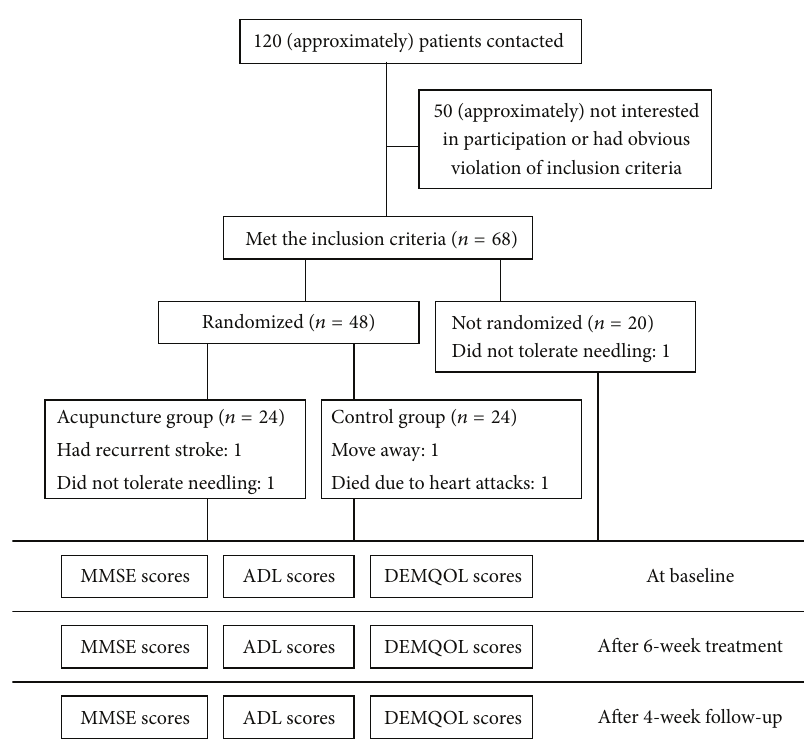
Figure 1: Trial flow